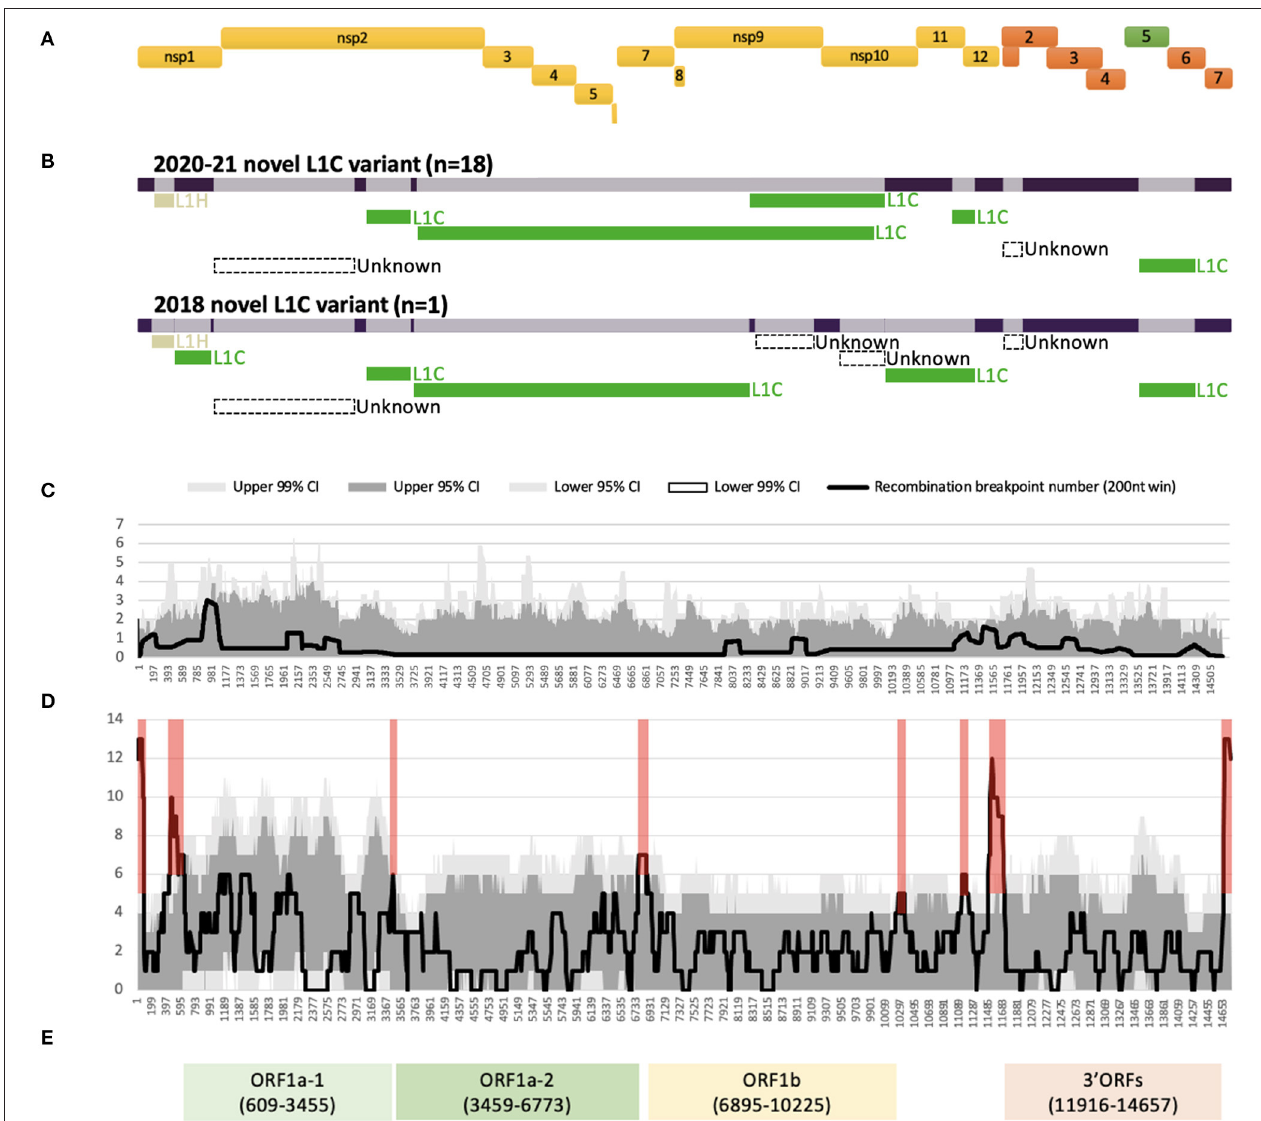
FIGURE 1 | Recombination profile of the novel L1C-1-4-4 viruses in relation to PRRSV-2 genomic organization. (A) PRRSV-2 genomic organization. (B) Putative recombinant regions and minor parents of the 2020–21 ( n = 18) and the 2018 ( n = 1) L1C-1-4-4 variants. The long bar across the top represents the viral genomic backbone. The smaller bars below represent putative minor parents labeled according to the ORF5-based sub-lineages. (C) Recombination breakpoint distribution of the novel L1C-1-4-4 WGSs as queries against other PRRSV-2 WGSs. (D) Overall recombination breakpoint distribution of the 251 PRRSV-2 WGSs. Recombination hotspots defined by the local density plot are highlighted in red. (E) Genomic fragments with low within-fragment recombination rates used for phylogenetic analyses. Nucleotide positions in the alignment are shown in the parenthesis.